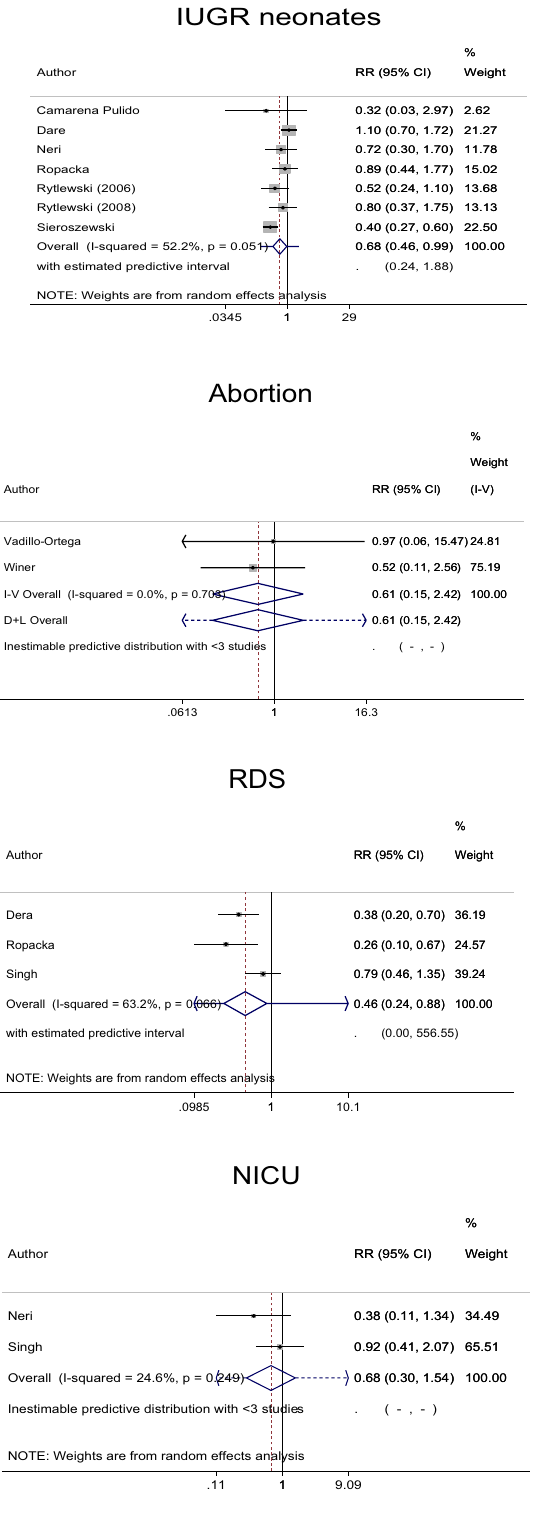
Figure 2. Forest plots of dichotomous birth outcomes. D + L, DerSimonian & Laird; ICH, intracranial haemorrhage; IUGR, intrauterine growth retardation; I-V, inverse variance; NICU, neonatal intensive care unit; RDS, respiratory distress syndrome. The model of DerSimonian & Laird is used when D + L or I-V is not attached to ‘Overall’. In comparison to controls, the oral l-arginine groups showed significantly reduced risks of IUGR neonates, pre-term birth and respiratory distress syndrome ( n = 7, 3 and 3, respectively) in the total